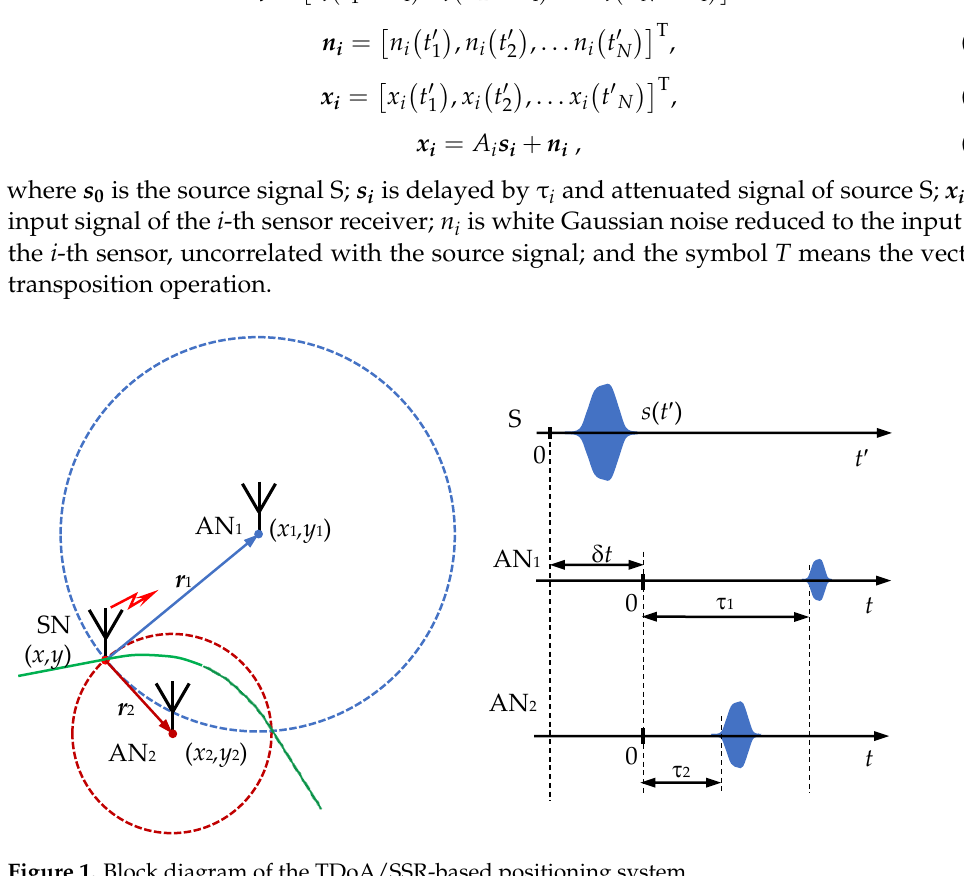
Figure 1. Block diagram of the TDoA/SSR-based positioning system.